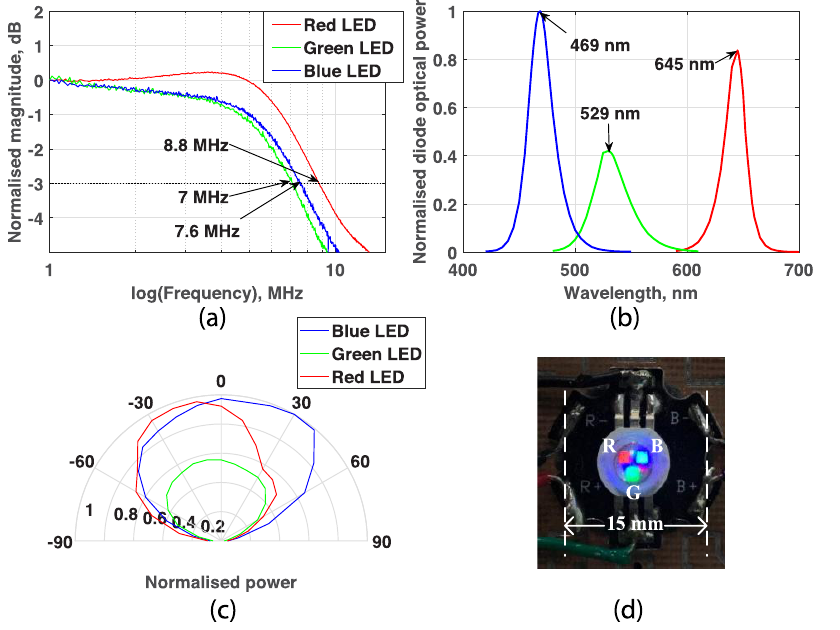
Figure 4. RGB LED: ( a ) normalized frequency response; ( b ) power profiles; ( c ) beam profile; and ( d ) LED.